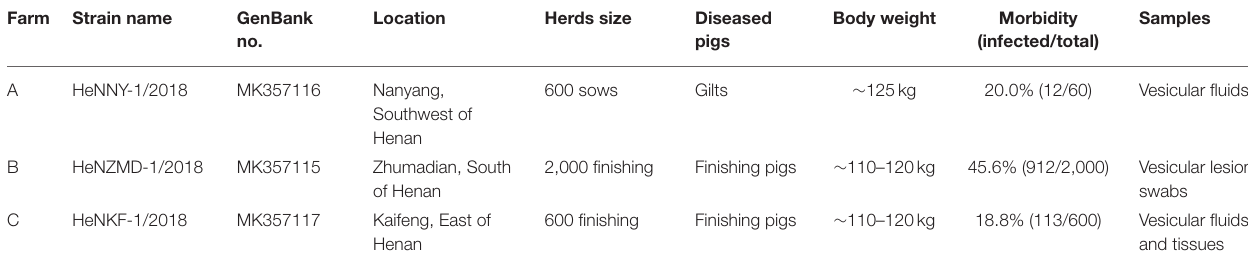
TABLE 1 | The geographical distribution of 3 pig farms and the detailed status of swine